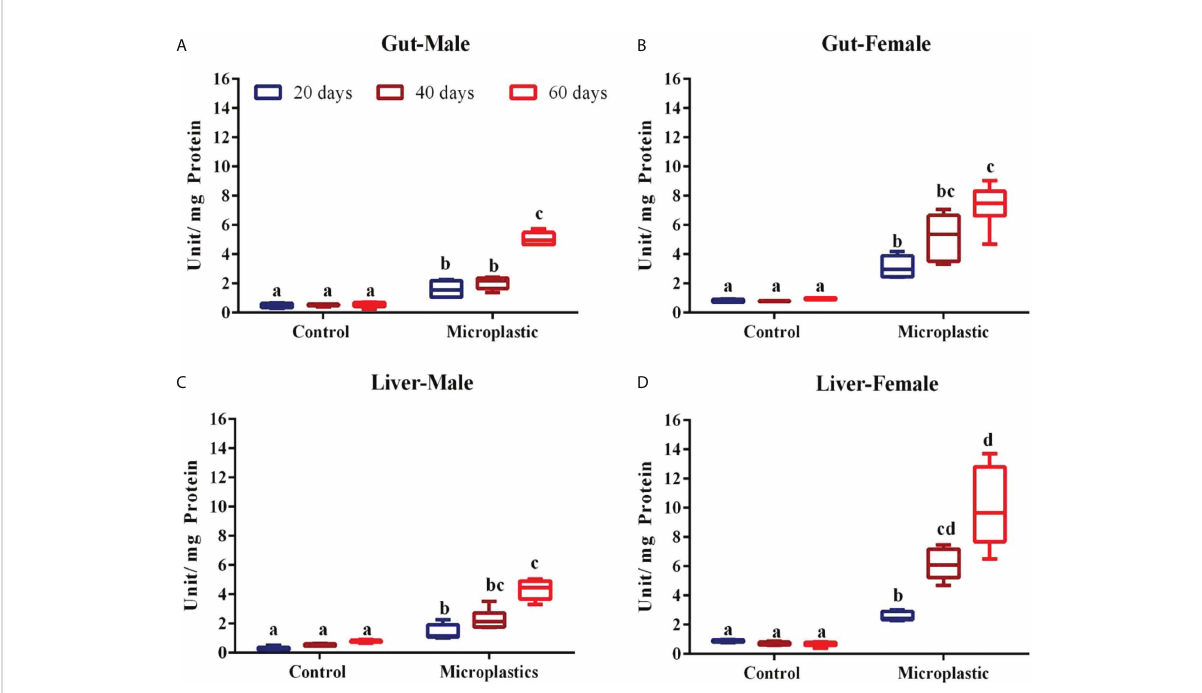
FIGURE 2 Showing the level of glutathione-S-transferase enzyme level in fi sh exposed to weathered polyethylene microplastics (A) Gut Male, (B) Gut Female, (C) Liver Male, (D) Liver Female. The line in each box represent median and whiskers represents the upper and lower 95% con fi dence intervals of the mean of six determinations using samples from different preparations. One-way analysis of variance (ANOVA) followed by Tukey ’ s post hoc test was used. The signi fi cant ( P < 0.05) differences between control and exposure groups were indicated by the alphabets; same alphabet shows no signi fi cant difference with respective control group. Different alphabet shows the signi fi cant difference with control respective